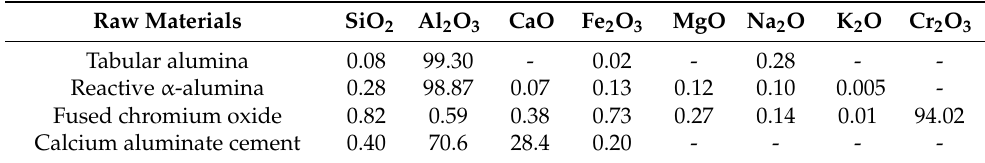
Table 1. The chemical composition of raw materials (wt%).